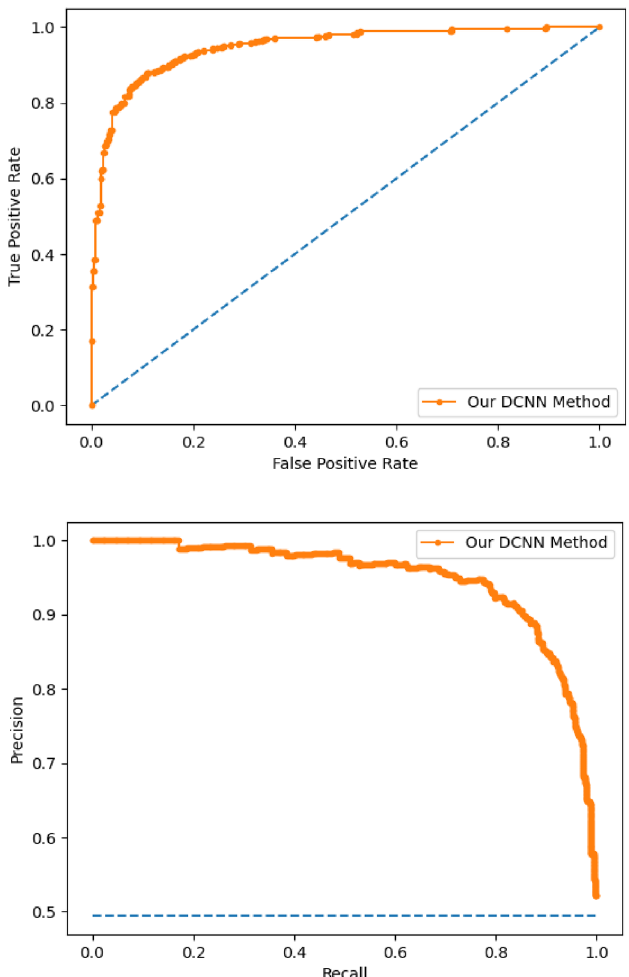
Figure 7. ROC and precision-recall